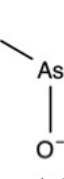
Table 1. In vivo and in vitro study design.